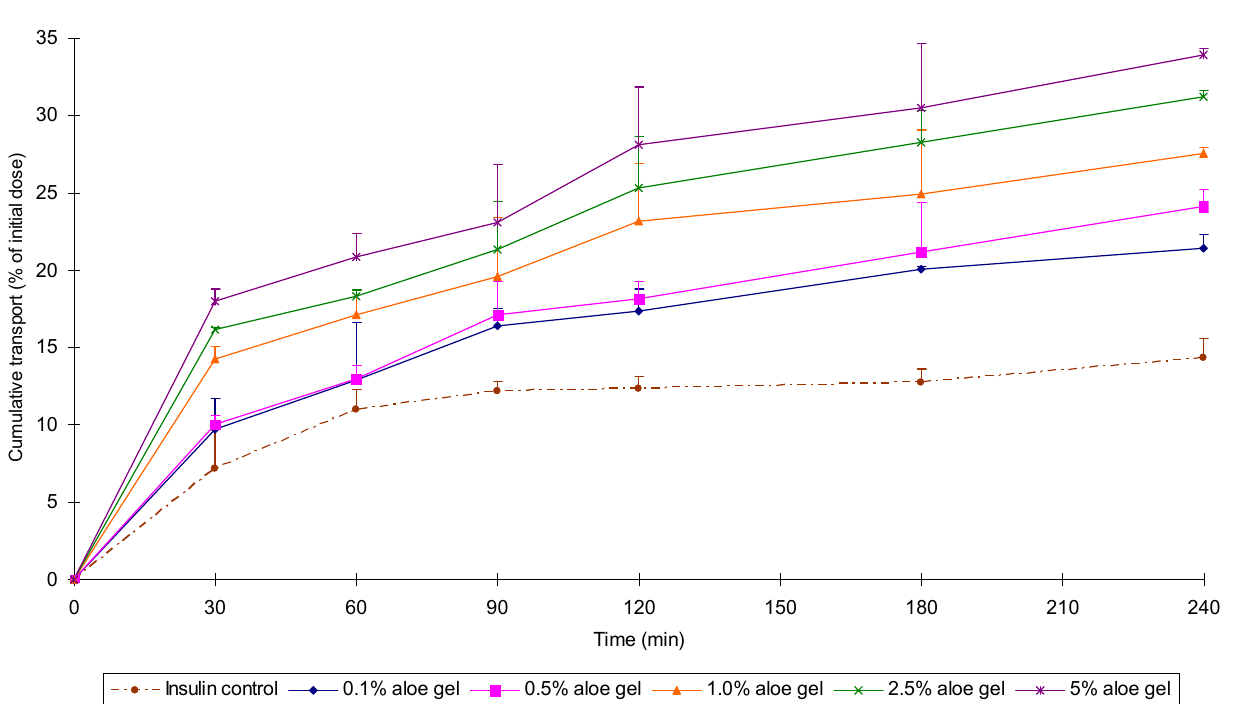
Figure 4. The effect of A. vera gel on the transport of insulin across Caco-2 cell monolayers at pH 7.4